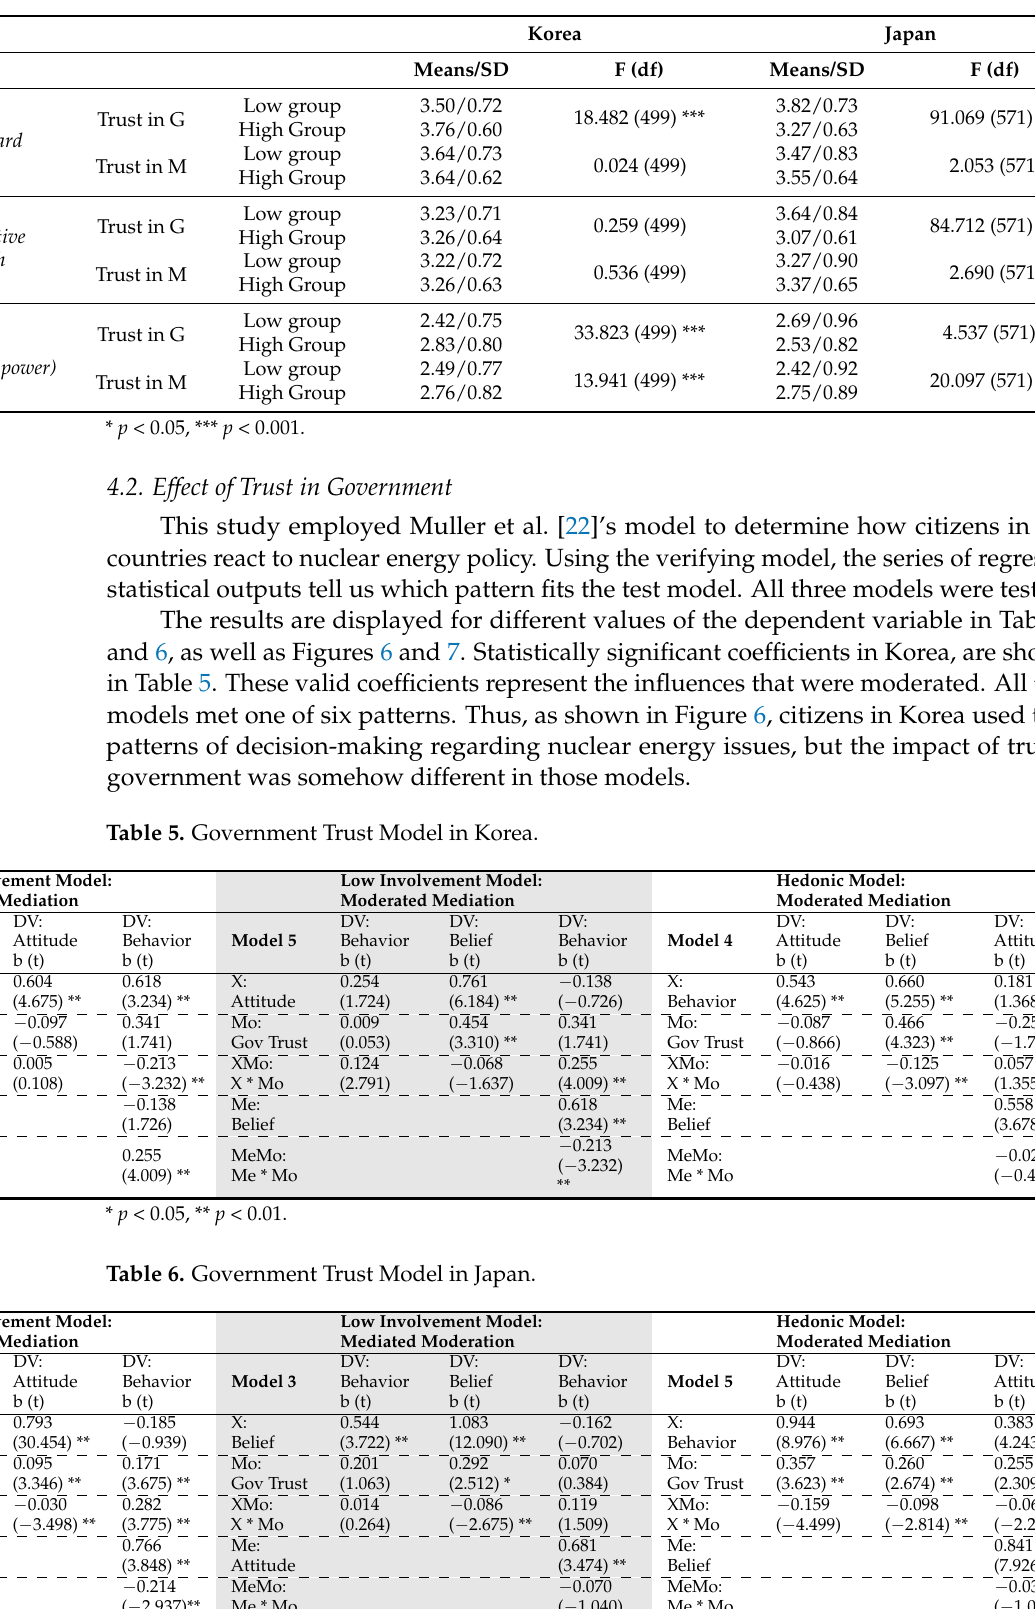
Table 4. ANOVA Test on Belief, Attitude, and Behavior.